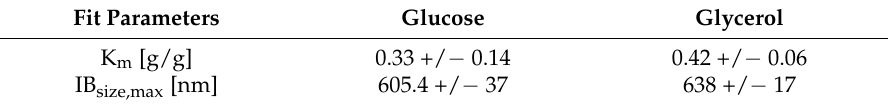
Table 2. Fitting results for hyperbolic-fit Equation (3) for IB bead size dependence.